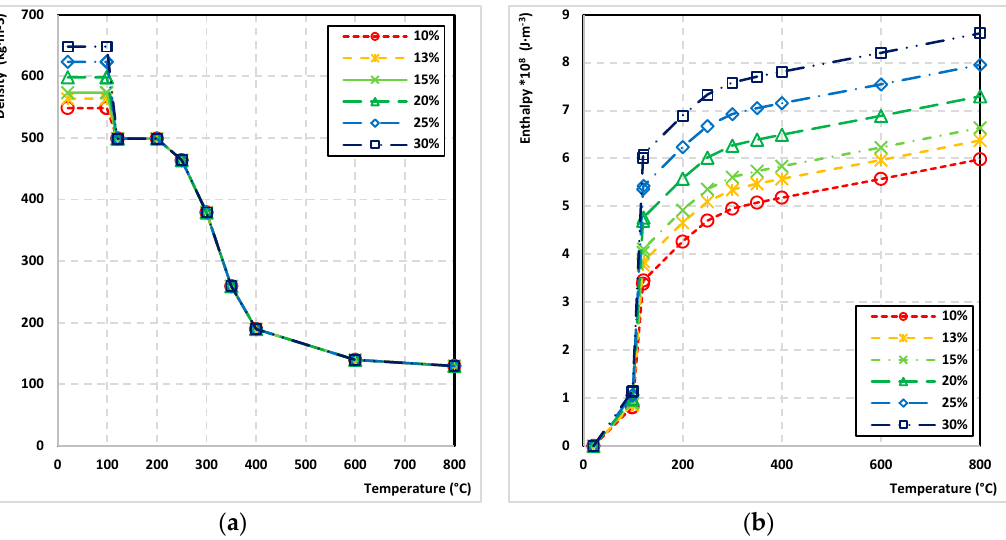
Figure 6. The properties for different moisture content in wood: ( a ) density and ( b ) enthalpy.